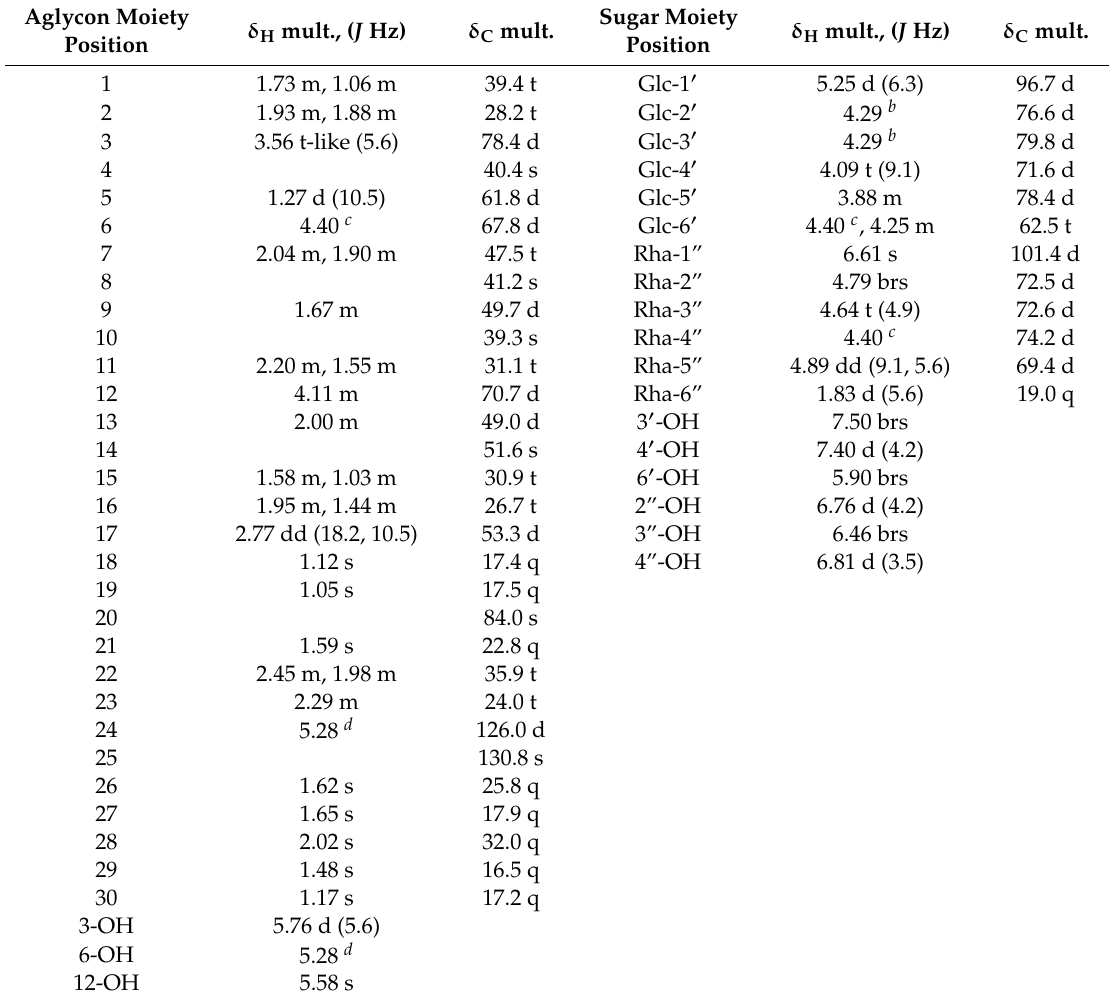
Table 1. 1 H- (700 MHz) and 13 C-NMR (175 MHz) spectra of